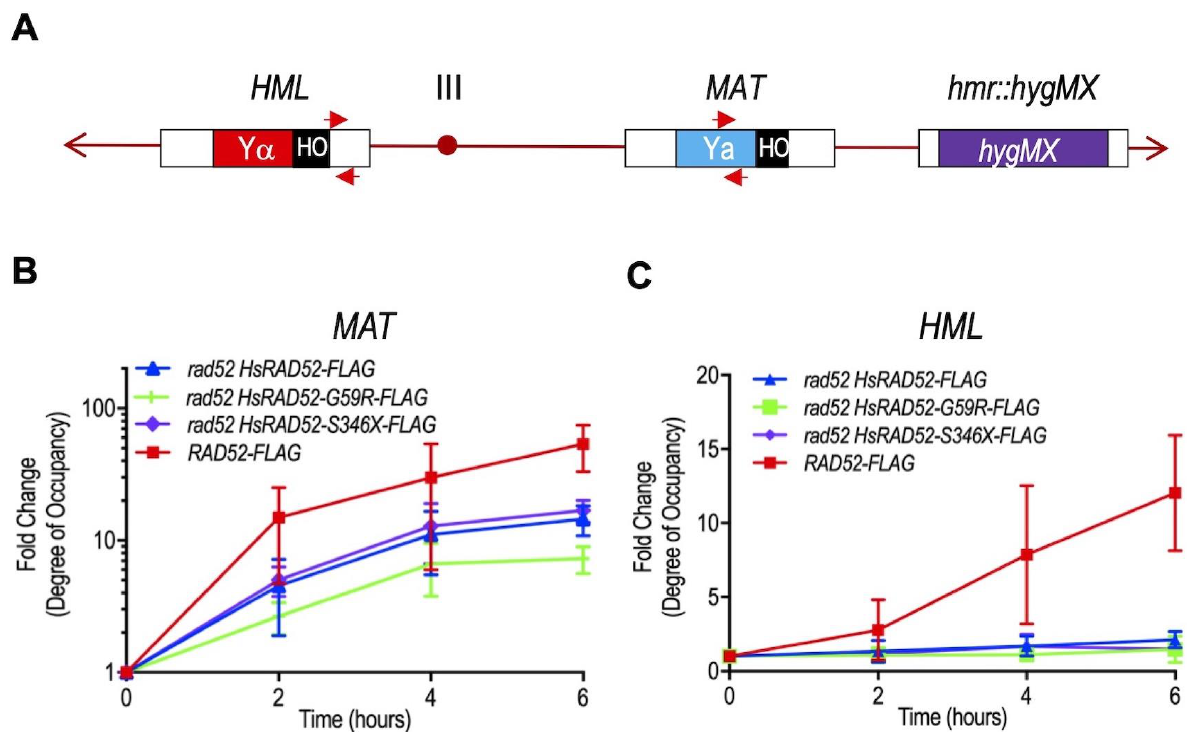
FIGURE 6: The adh1::HsRAD52-G59R-FLAG and adh1::HsRAD52-S346X-FLAG alleles have differential effects on the interaction of HsRAD52 with the MAT and HML loci during MTI. (A) Cartoon depicting substrates for MTI and location of primers used for quantitation of immuno- precipitated genomic sequences. Following DSB formation by HO endonuclease at the HO cut site (black box) at the MAT locus on chromo- some III, exonucleolytic processing results in the accumulation of ssDNA in flanking sequences. ScRad52-FLAG, or HsRAD52-FLAG progressive- ly associate with the ssDNA. This association facilitates retention of the DNA sequences by ChIP, which are quantitated by qPCR using MAT a recipient primers (red arrows; Table S3) complementary to a 110 bp sequence laying 500 bp upstream from the DSB at MAT . Deletion of the HMR locus and replacement with a hygMX marker (purple box) removes additional complementary sequences from the genome. After asso- ciation with ssDNA at MAT , the HRR apparatus facilitates a search for homologous genomic sequences that gives rise to heteroduplex for- mation with the intact HML locus. The sequences that lay proximal to the HO cut site at the border of Y ⍺ (red box) are the putative initial location for heteroduplex formation. Association of ScRad52-FLAG or HsRAD52-FLAG with the heteroduplex results in retention of these se- quences by ChIP, and their quantitation is done by qPCR using HML ⍺ donor primers (red arrows; Table S3) complementary to a 187 bp se- quence laying 67 bp downstream from the HO cut site sequence at HML . (B) ScRad52-FLAG and HsRAD52-FLAG display similar kinetics of association with sequences at the MAT locus after DSB formation. Single colonies of wild-type (ABX3961-4C), rad52 (ABX3943-3B), rad52 adh1::HsRAD52-FLAG (ABX3977-10C), rad52 adh1::HsRAD52-G59R-FLAG (ABX3985-55B), and rad52 adh1::HsRAD52-S346X-FLAG (ABX3994- 18D) strains carrying MTI assay components were used to establish cultures from which aliquots were collected at various times before and after DSB formation at the MAT locus by HO endonuclease. Whole cell extracts were prepared, subjected to ChIP using anti-FLAG antibody and the immunoprecipitated DNA from the MAT (experimental) and SAM1 (control) loci quantitated by qPCR. Fold changes in degree of oc- cupancy of the FLAG-tagged proteins relative to those observed before DSB formation were normalized to a control strain lacking FLAG- tagged proteins (ABX3933-46C). Mean fold changes from at least eight determinations using DNA collected from at least three independent time courses, and standard deviations were plotted against elapsed time after initiation of DSB formation. (C) HsRAD52-G59R-FLAG and HsRAD52-S346X-FLAG display defects in association with the HMR locus during MTI. Same as above except immunoprecipitated DNA from the HMR locus (experimental) was quantitated by